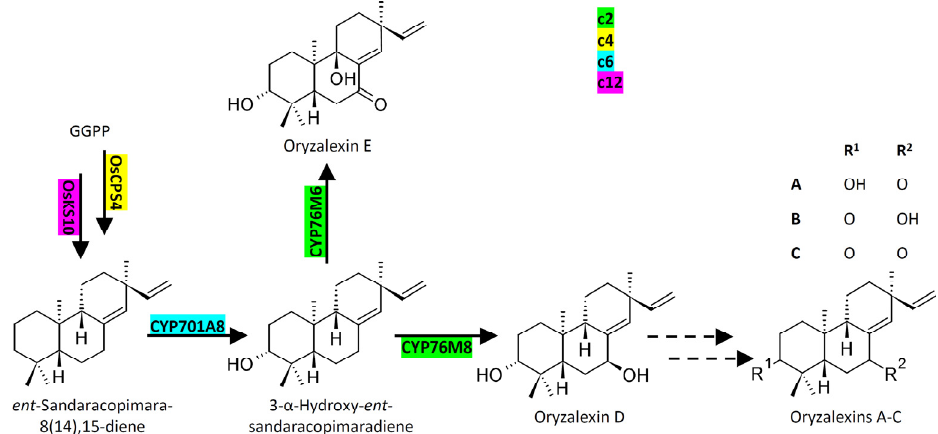
Figure 10. Proposed pathway for the biosynthesis of oryzalexins A–E. Enzymes encoded by genes located on chromosomes 2, 4, 6, and 12 (c2, c4, c6, c12) are highlighted in green, yellow, blue, and pink, respectively. A, B, C: oryzalexin A, B, and C, respectively. CYP701A8: ent -sandaracopimara- diene 3-hydroxylase (EC 1.14.14.70); CYP76M6: oryzalexin E synthase (EC 1.14.14.122); CYP76M8: